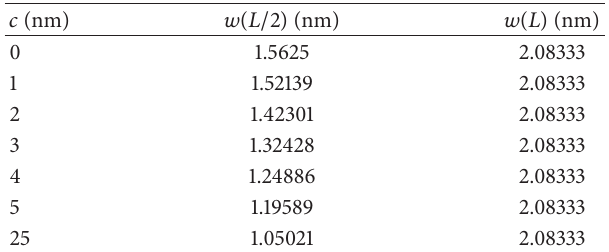
Figure 3: Axial displacement in terms of the nonlocal parameter 𝑐 at the abscissa 𝑧 = 𝐿/2 (blue line) and 𝑧 = 𝐿 (red line). Table 1: Axial displacements 𝑤(𝐿/2) and 𝑤(𝐿) versus the nonlocal parameter 𝑐